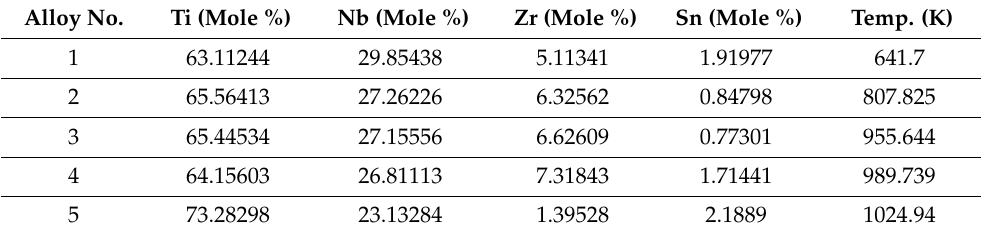
Table 4. Candidate alloys predicted through CALculation of PHAse Diagram (CALPHAD), DLANN models and SOM approach, with zero concentrations of HCP_A3 ( α ), ALTI3_D019 ( α ”), and OMEGA ( ω ) phases. Alloy No. Ti (Mole %) Nb (Mole %) Zr (Mole %) Sn (Mole %) Temp. (K) 1 63.11244